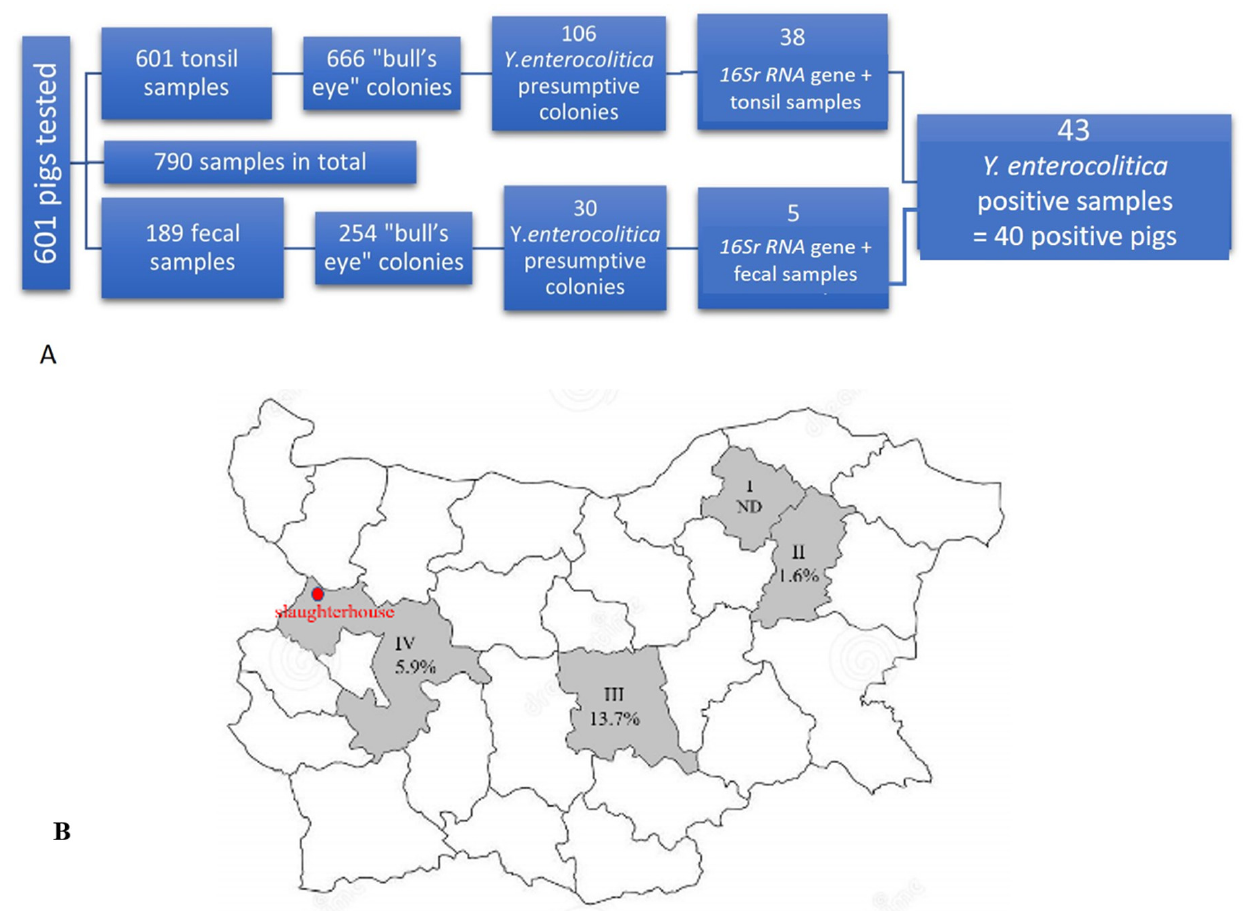
Figure 1. Numbers of pigs and samples tested for Yersinia enterocolitica ( A ) and the distribution of the positive pigs per region in Bulgaria ( B ). Regions are presented in roman numerals I: Razgrad region (Farm I), II: Shumen region (Farm II), III: Stara Zagora region (Farm III), and IV: Sofia region (Farms IV, V, VI, and VII). The red dot indicates the location of the slaughterhouse (Kostinbrod city). Total prevalence of Y. enterocolitica in slaughter age pigs was calculated to be 6.7%